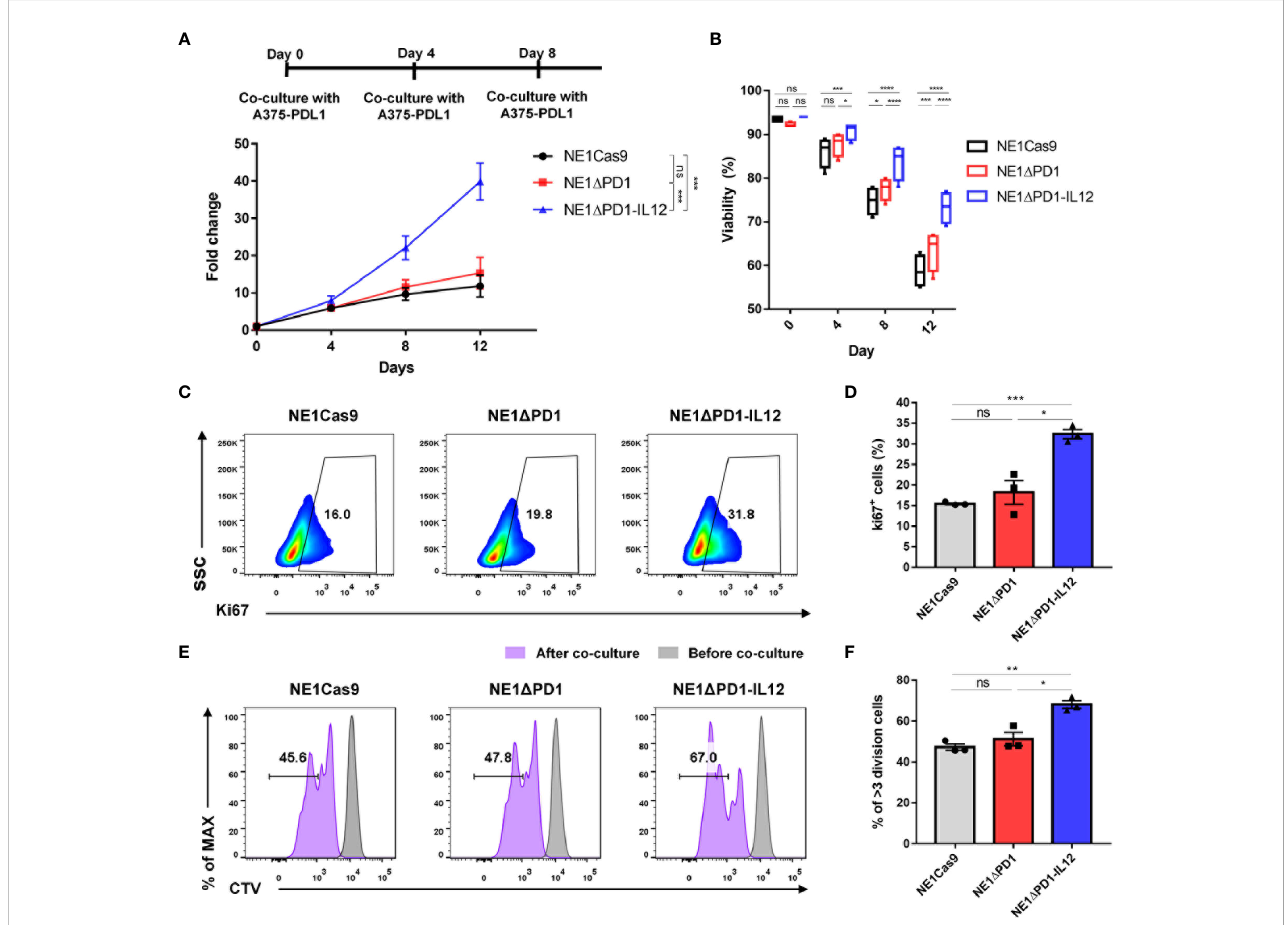
FIGURE 4 Enhanced cell expansion of D PD-1-IL-12-edited NY-ESO-1 TCR-T cells during repeated tumor challenge (A) The expansion engineered T cells was analyzed after repetitive stimulation with mitomycin C-pretreated A375-PDL1 cells three times every 4 d. Data are presented as the mean ± SEM (n = 4; four independent experiments with individual donors). (B) The viability of expanded T cells in A was measured using a Countess II automated cell counter with Trypan Blue staining. (C) Representative fl ow plot for Ki67 expression after the third stimulation in (A, D) The percentage of Ki67 + T cells after